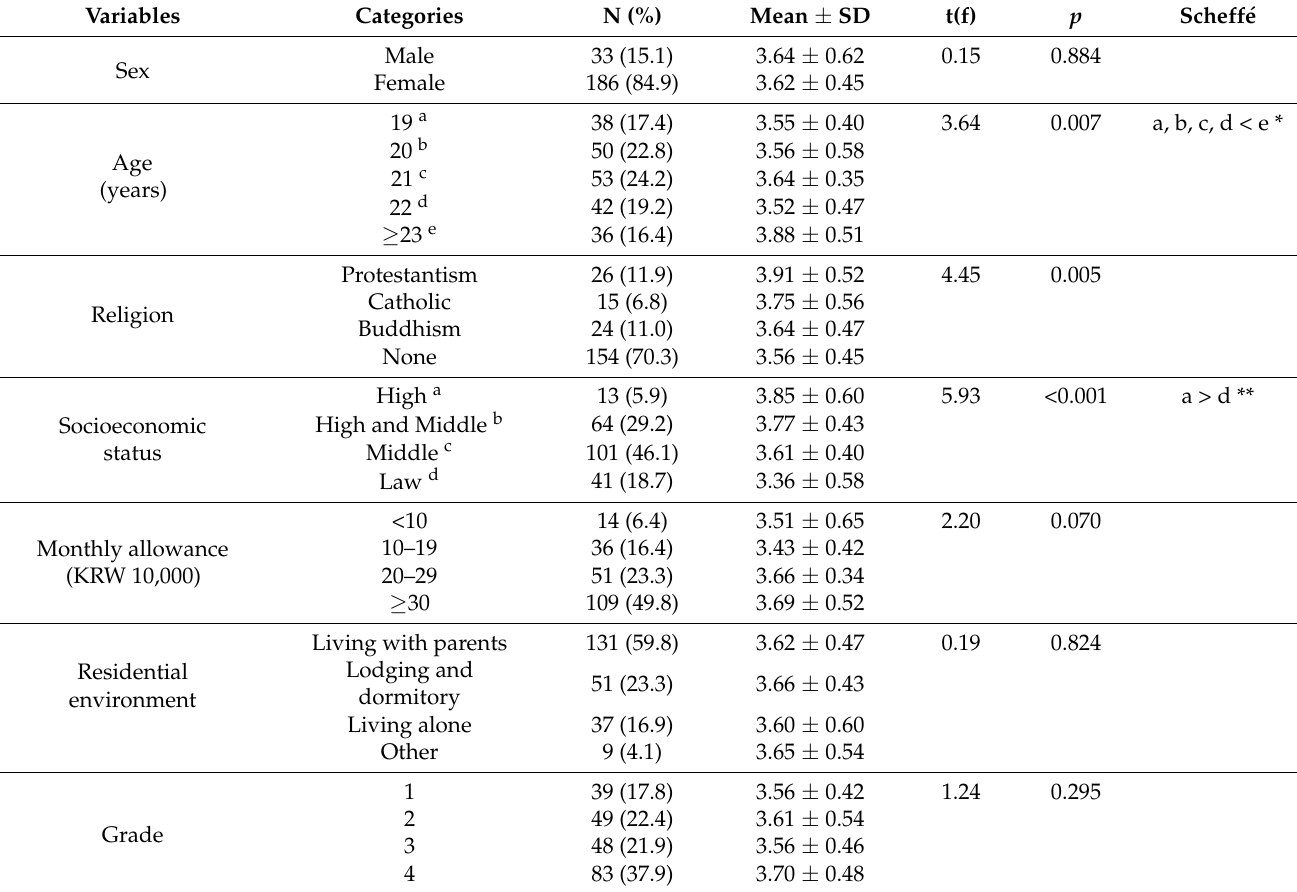
Table 1. Spiritual health according to participants’ general characteristics ( N =